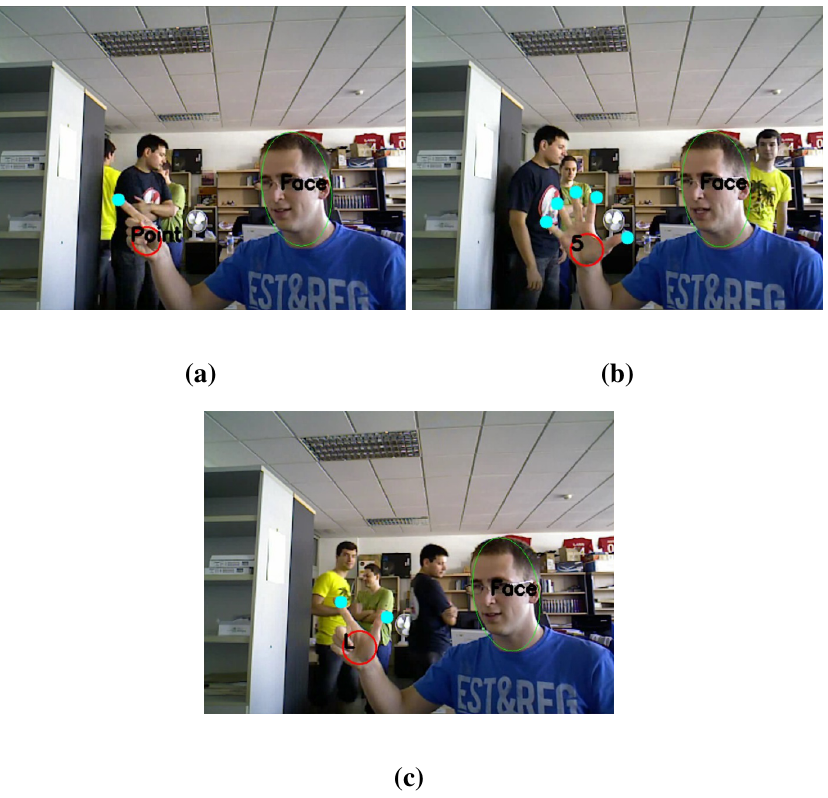
Figure 13. Examples of the system performance in presence of cluttered